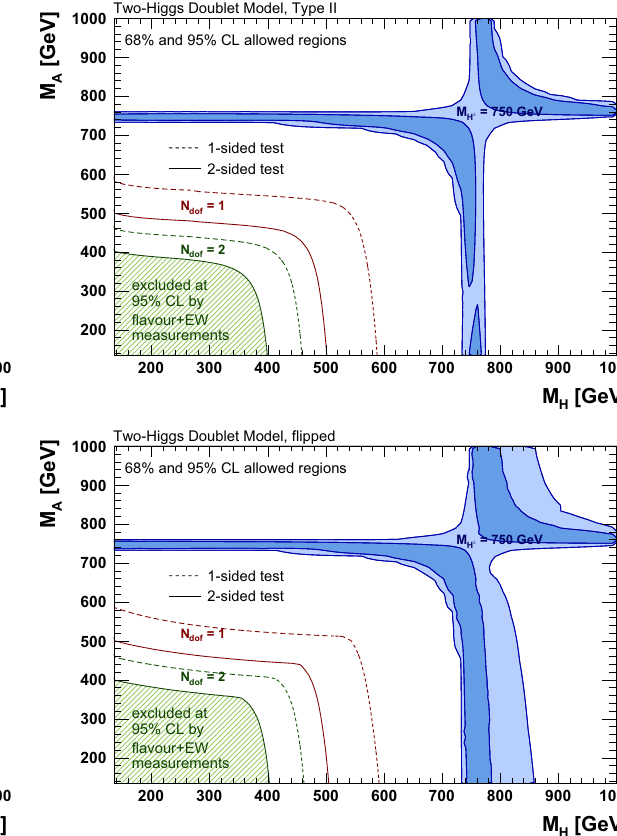
Fig. 12 2HDM fit results using a combination of constraints from the Higgs-boson coupling strength measurements, flavour observables, muon anomalous magnetic moment, and electroweak precision data. Shown are allowed 68 and 95% CL regions in the M A versus M H plane